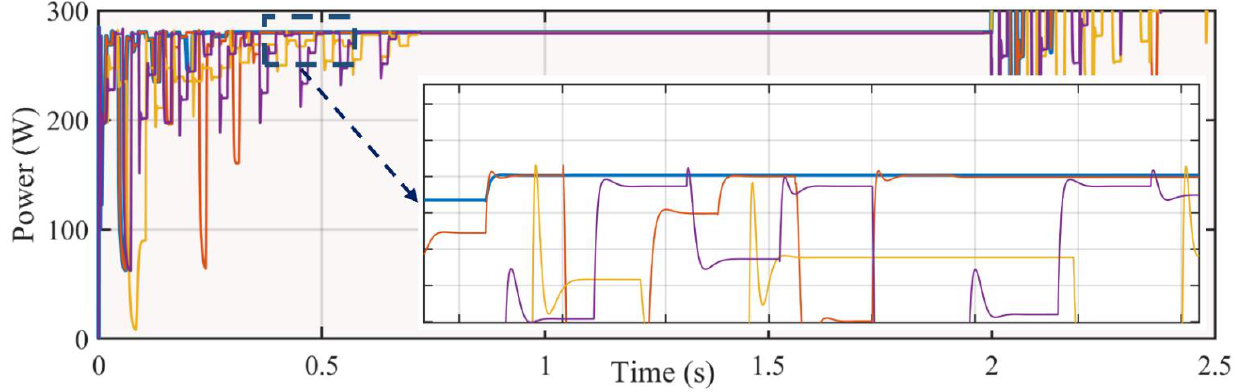
Figure 17. Competing techniques zoomed-in power Case-2.